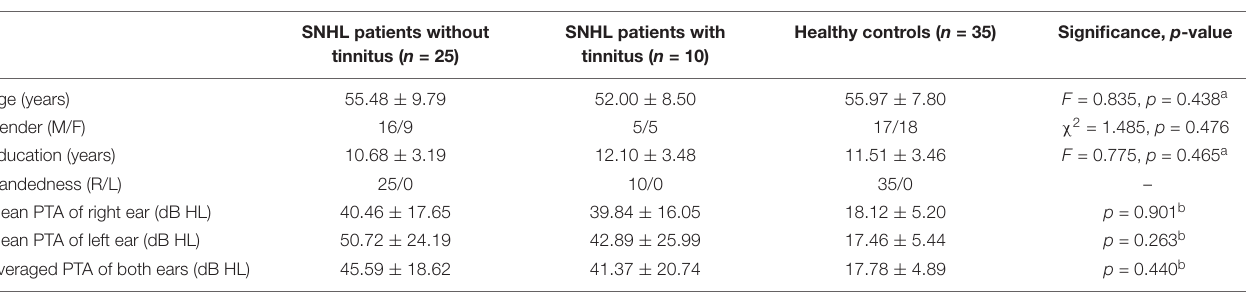
TABLE 2 | Demographical and clinical comparisons of the SNHL subgroups and control